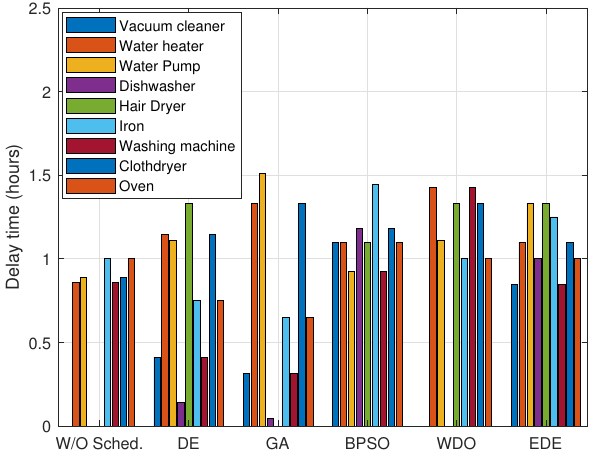
Figure 22. User comfort in aspects of average waiting time after scheduling hybrid appliances.